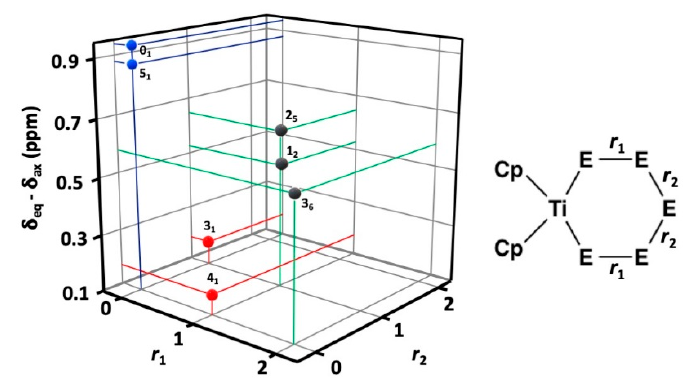
Figure 5. The difference between the 13 C chemical shifts as a function of heteronuclear Se–S bonds in positions r 1 and/or r 2 ( r i = 0, 1, 2). The data points in blue mark complexes with no heteronuclear chalcogen-chalcogen bonds ( 0 1 and 5 1 ), those marked in red indicate complexes with one Se–S bond either in position r 1 or r 2 , and those in grey indicate two Se–S bonds either in positions r 1 or r 2 .